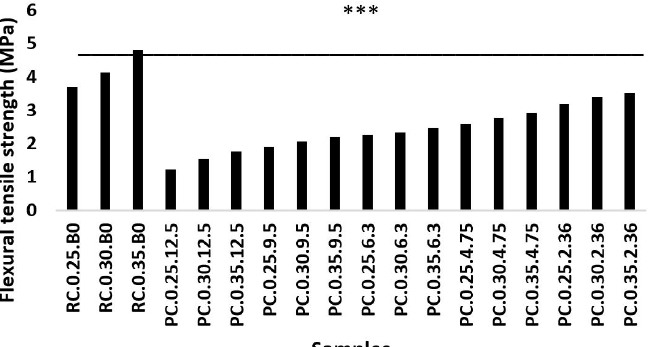
Figure 9 A verage samples results of flexural tensile strength tests. *** Statistically significant difference by the Tukey test p <0.001.